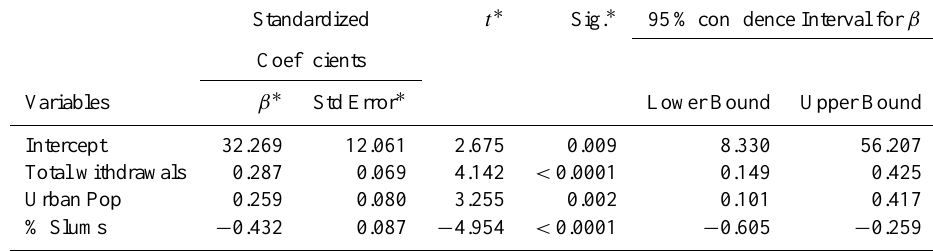
Table 6. Model parameters with Sanitation as dependent variable, stepwise method (adjusted R 2 =0.635).